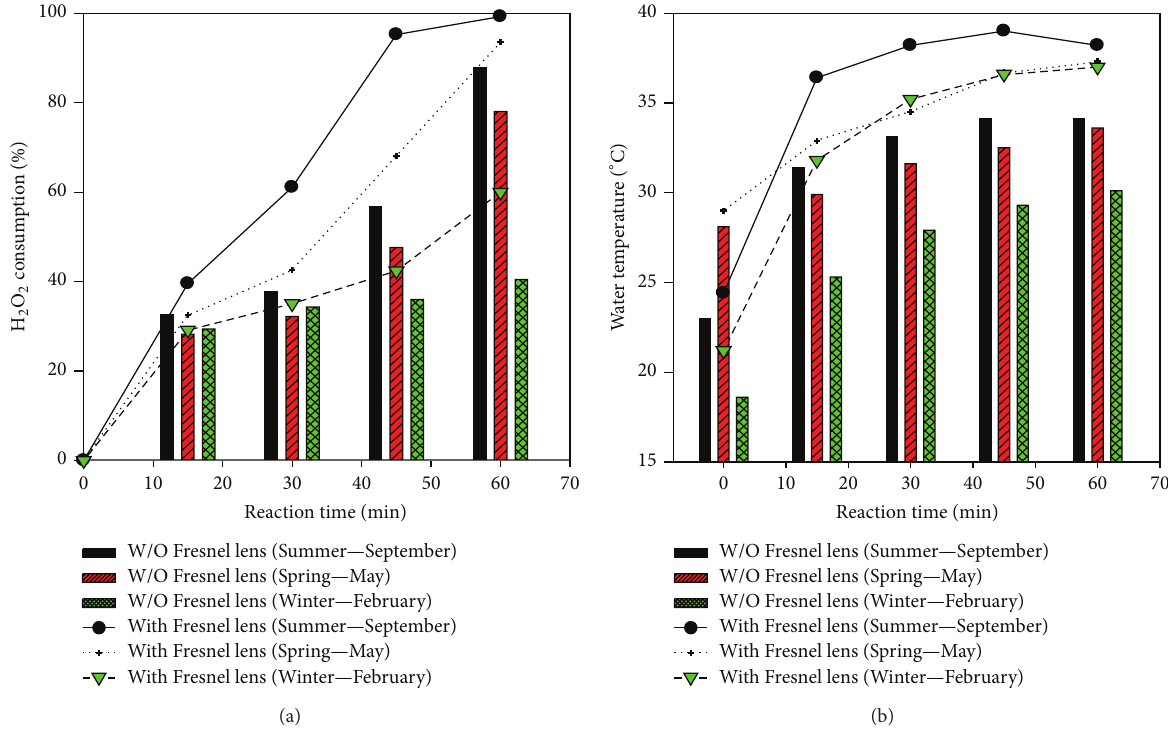
Figure 4: H 2 O 2 consumption (a) and water temperature (b) of the electro-optical industry wastewater treated by solar IPCC reactor in different seasons (initial pH: 3.0; [H 2 O 2 ] 0 /COD 0 = 2.0g/g; [H 2 O 2 ] 0 /[Fe 2+ ] 0 =